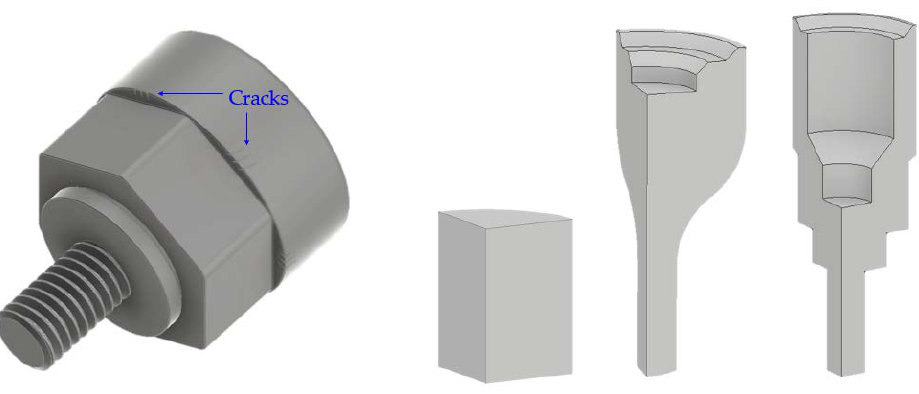
Figure 2. ( a ) Cracks appearing on side surface of a cold forged part; ( b ) sequence of cold forging operations